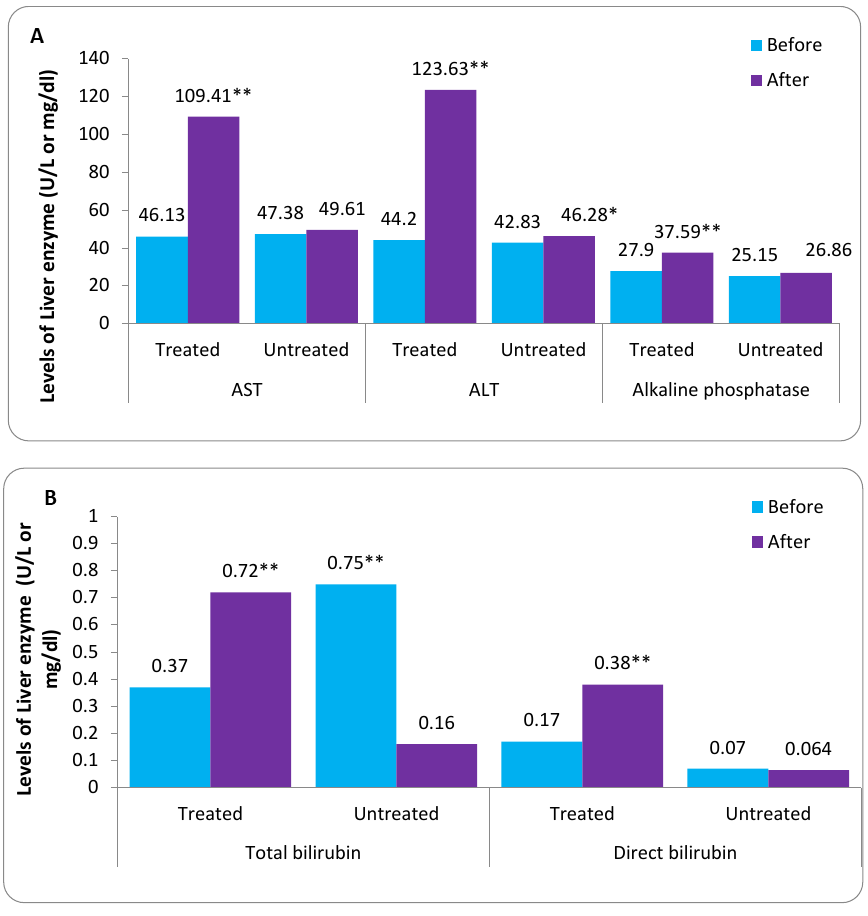
Figure 4. Comparison between before and after according to treated and untreated FPV Therapy ( A , B ). * Significant difference using paired t -test at p < 0.05 and ** at p < 0.01 The liver functions enzymes AST, ALT, alkaline phosphatase, and bilirubin levels at the end of this study after FPV therapy in treated and untreated groups are shown in Table 5. The statistical analysis shows a significant difference between treated and untreated